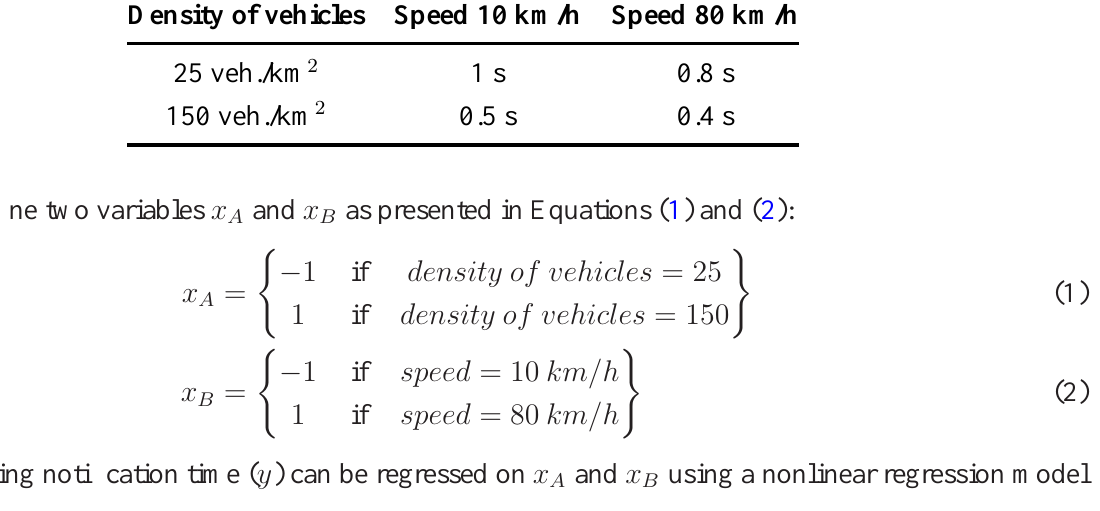
Table 2. Example of results obtained in terms of warning notification time varying two